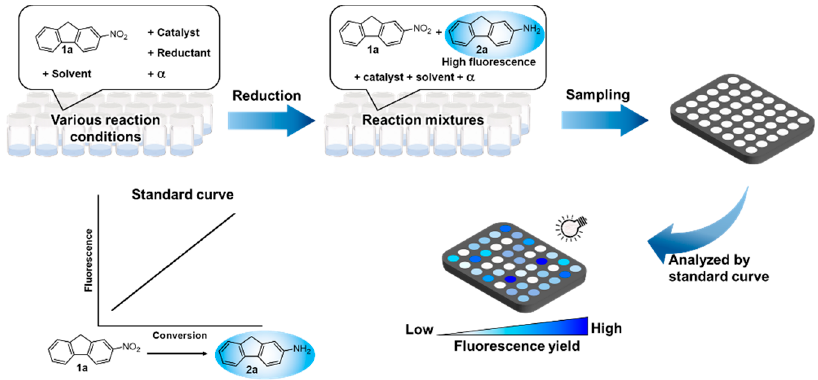
Scheme 1. Schematic representation of fluorescence-based high-throughput screening method for the reduction of